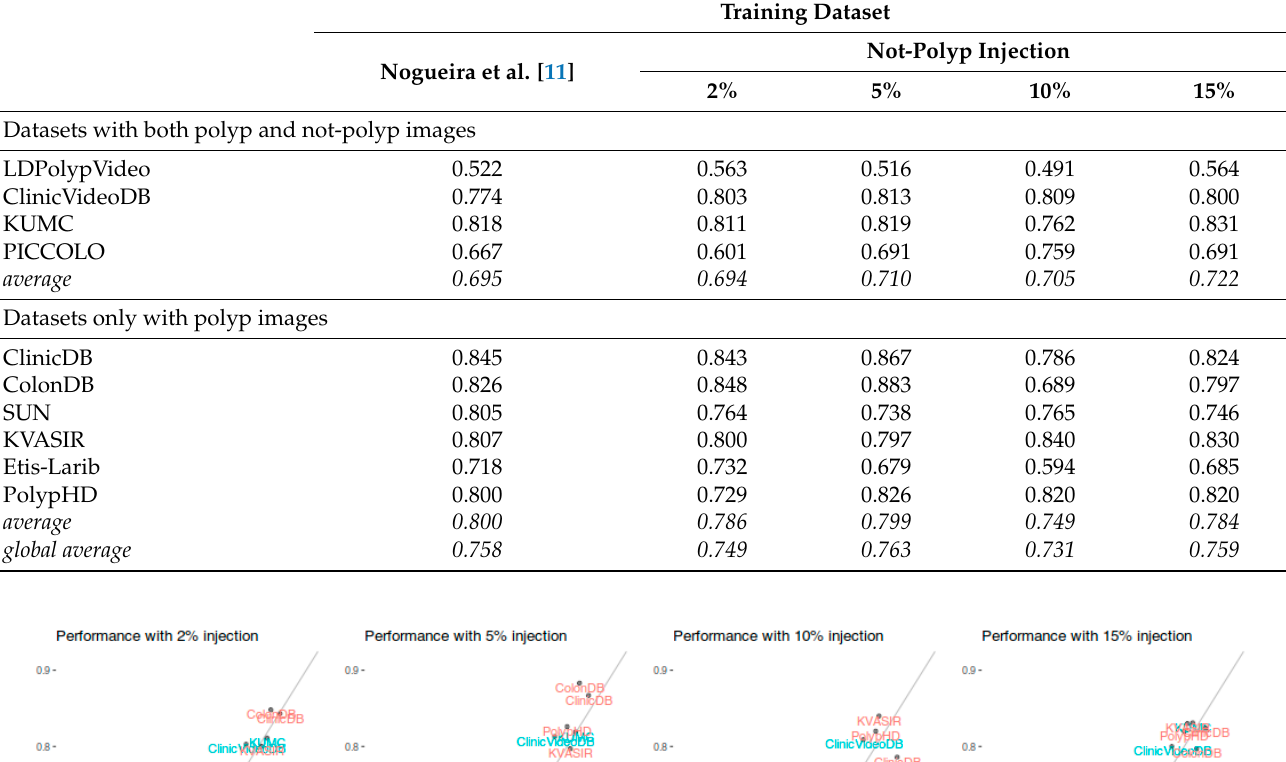
Table 5. F1 score of the five trained models in the 10 public datasets. Averages are provided for all datasets, datasets with both polyp and not-polyp images (4 datasets), and for datasets with only polyp images (6 datasets).